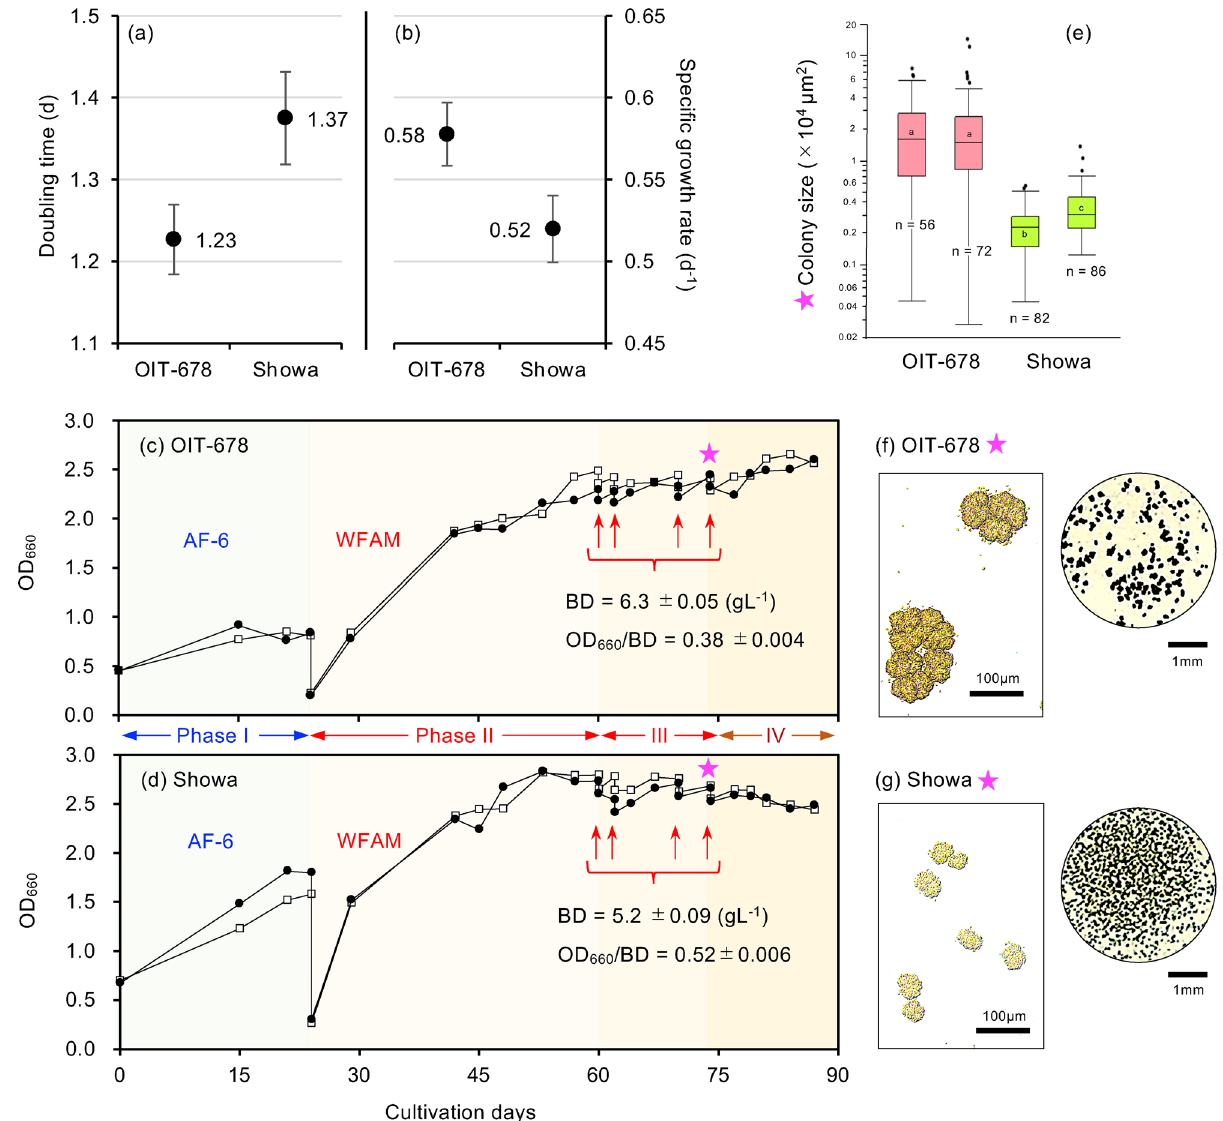
Figure 5. Growth rate, biomass density, and colony size of a novel fast-growing strain, Botryococcus braunii OIT-678, compared with the Showa strain. ( a , b ) Fast-growing potential was assessed by a 500 mL fed-batch culture (4 replicates for each strain), in which 40% of the culture volume is replaced by new culture medium every 2 days. Until the 10th day of cultivation, biomass growth rates of two consecutive sampling points were calculated, and their averages were compared between strains. ( c , d ) Potential for a high-density culture was assessed by using a nutrient-rich medium, WFAM. First, 1 g L −1 of algae were inoculated and cultivated in two 500 mL bottles for each strain with AF-6 culture media for 24 days (Phase I). Algal density was monitored by OD. At the end of Phase I, 83 mL of 6 × WFAM were prepared in new 500 mL bottles, and 415 mL of algal culture was transferred to the bottle and cultivated (Phase II). From the 60th to the 75th day, 5% of the algal culture was sampled four times (red arrows), and the same amount of 6 × WFAM was added. This gradually increased the concentration of the media up to 2 × WFAM (Phase III). Cultivation was continued until the 87th day of cultivation (Phase IV). ( e ) Colony size measured on the 75th day (star). The box plot indicates the range of 10–90% of the data with bars and the range of 25–75% of the data with a box. Wilcoxon signed-rank test results are shown by letters in the boxes, and significant differences between the samples are indicated by different letters ( P < 0.001). ( f , g ) Appearance of typical colonies: microscopic view (left) and macroscopic view